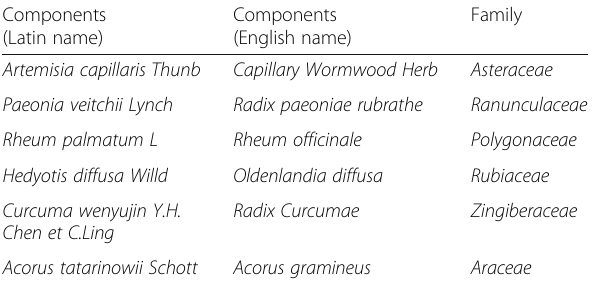
Table 1 Composition of JDHY granules Table 2 Food consumption of male rats treated with JDHY